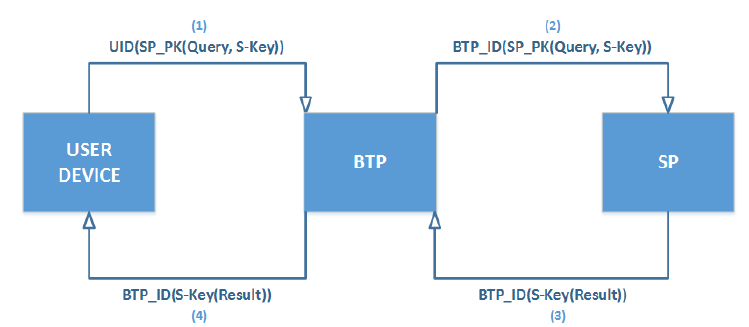
Figure 9. Blind Third-Party Technique